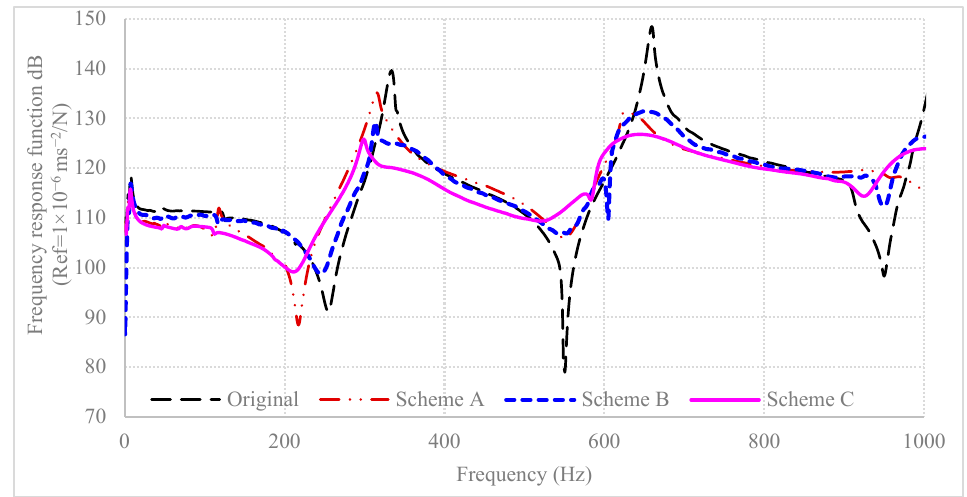
Figure 16. Frequency response function of pantograph strips under vertical excitation at point 9 in Figure 13.